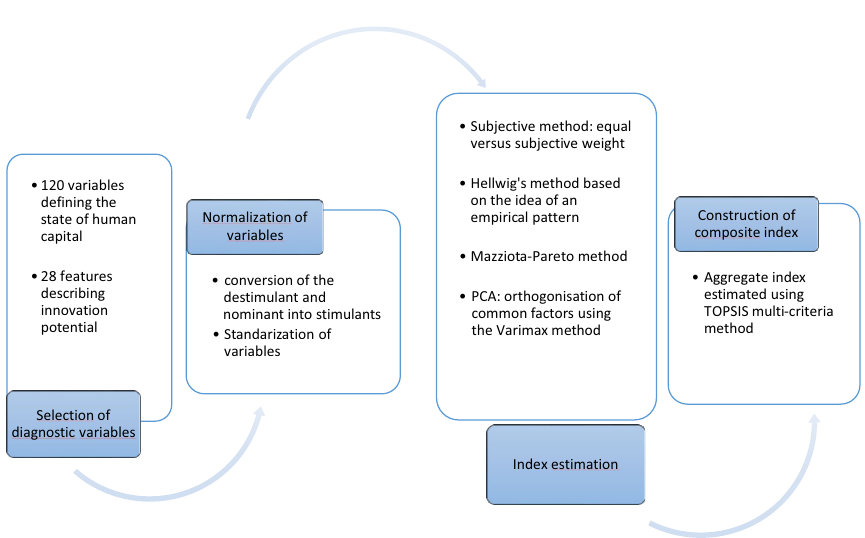
Figure 1. Algorithm of composite index construction (source: own